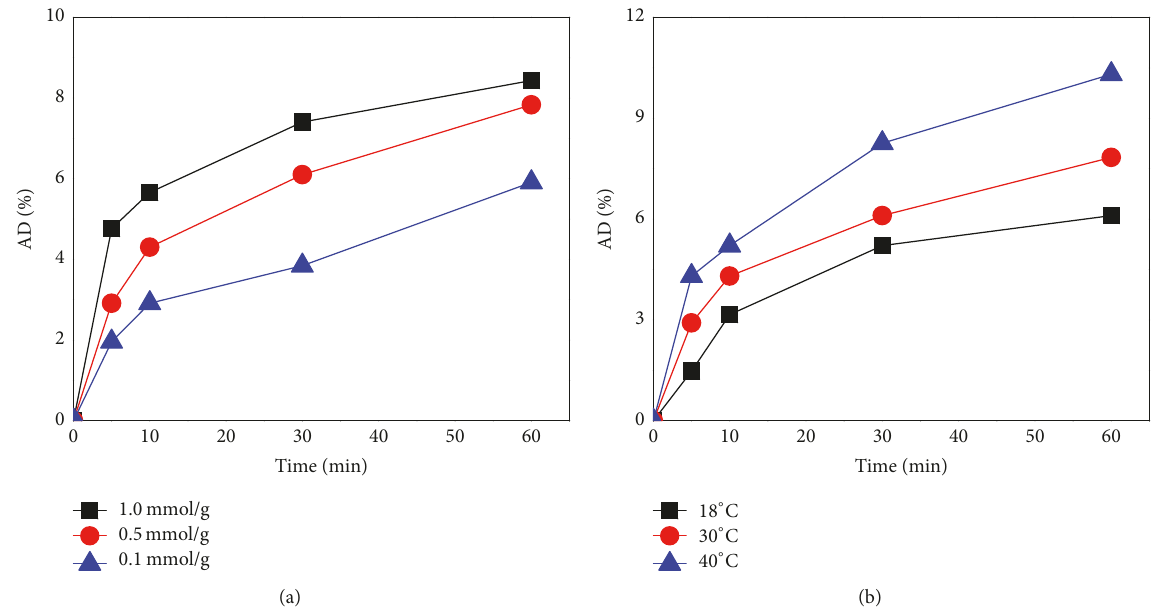
Figure 3: AD as a function of reaction time with different EDA concentrations at 30 ∘ C (a) and different reaction temperatures at an EDA concentration of 0.5 mmol/g.